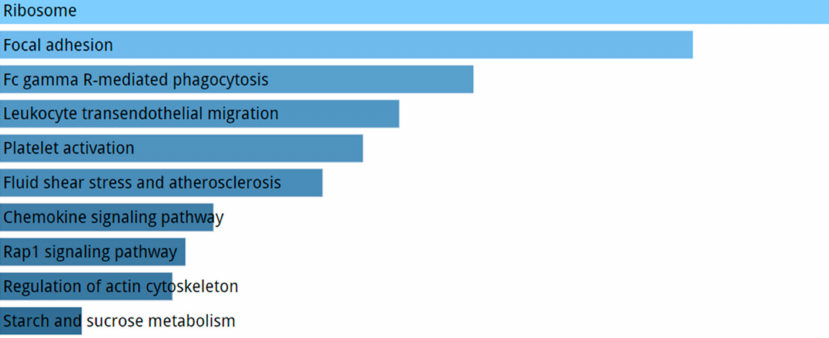
Figure 7. Pathways analysis performed with KEGG using DE genes in AD group compared to healthy controls. We report the top 10 KEGG terms. The significance of the specific gene-set term is represented by the length of the bar. The significance of the term is indicated by the brightness of the bar’s color (the brighter, the more significant).